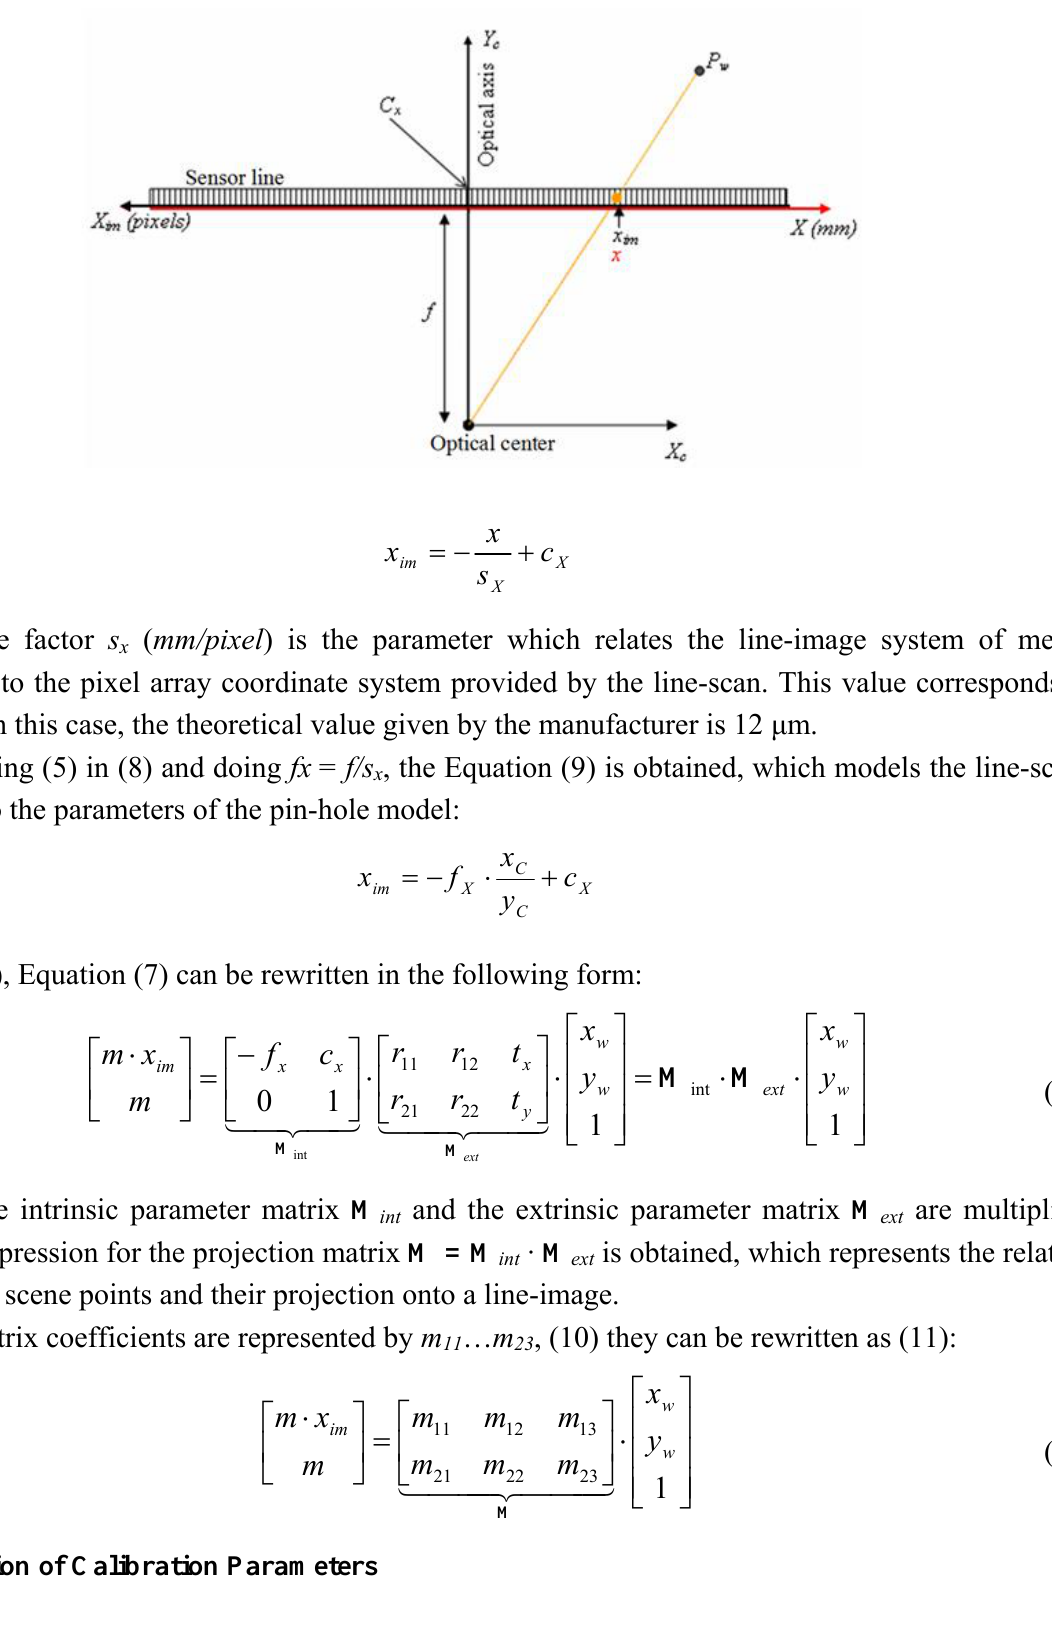
Figure 3. Diagram explaining the pin-hole model for a